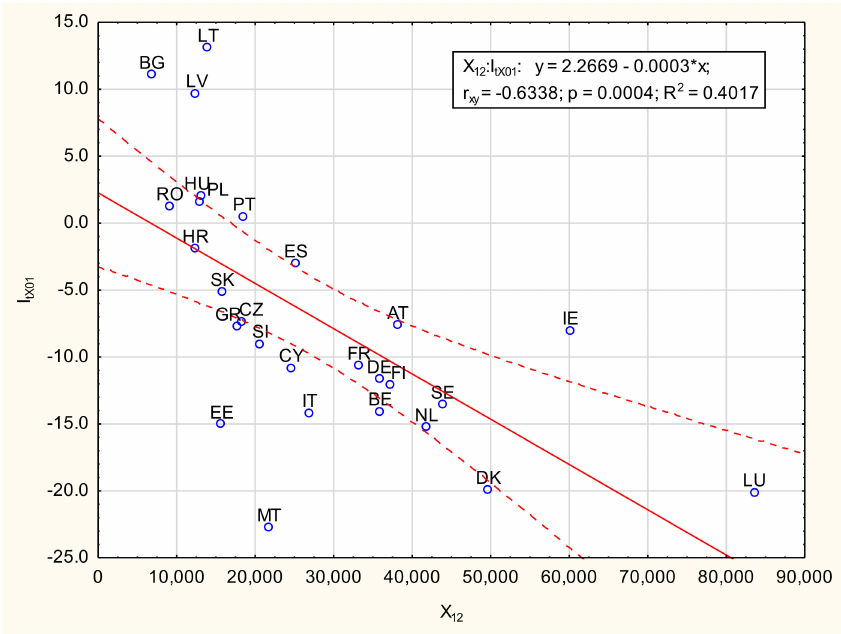
Figure 6. Correlation between change in primary energy consumption in 2010–2019 (I tX01 ) and GDP per capita in EU (27) countries in 2019 (scatterplot for variables I tX01 and X 12 ). Key: r xy —linear correlation coefficient; R 2 —coefficient of determination. Source: own work based on